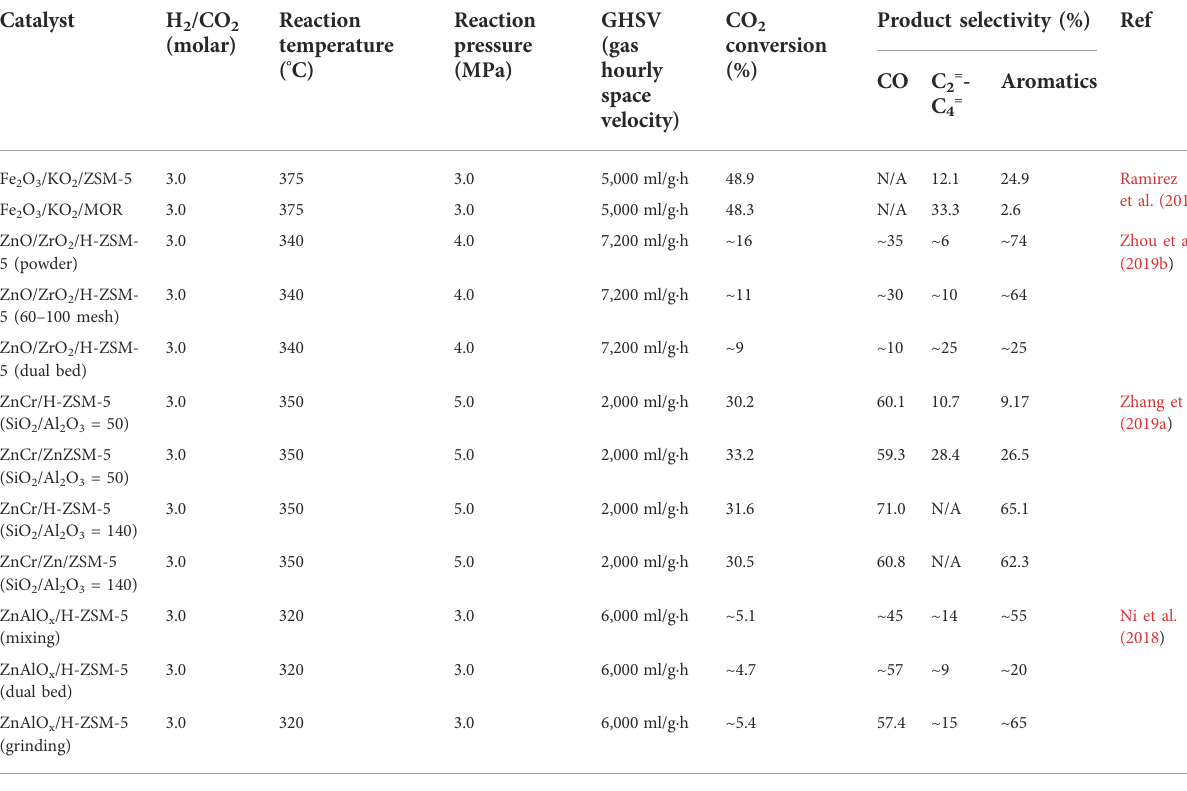
TABLE 2 Catalytic performances for the CO 2 conversion into light aromatics. Catalyst